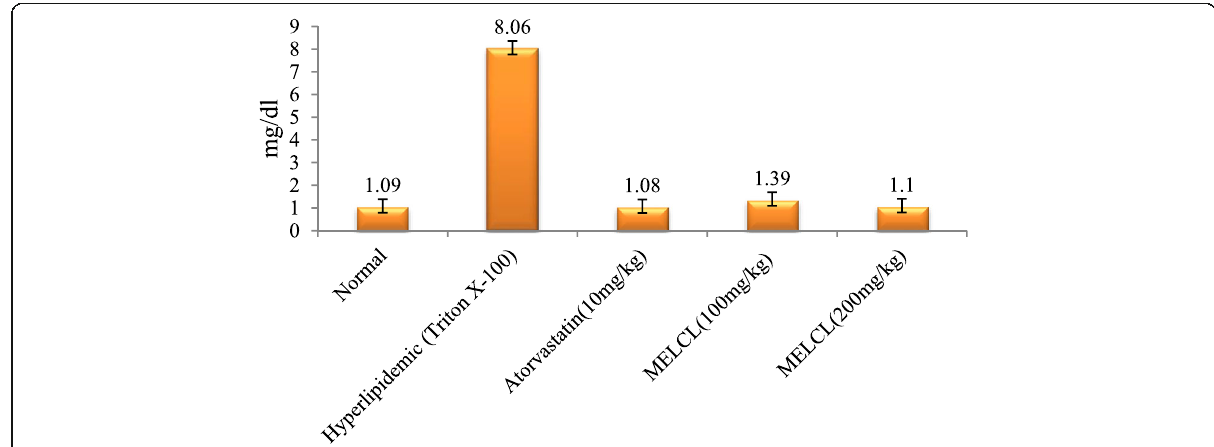
Fig. 3 Atherogenic index analysis for different groups. MELCL: Methanolic extract of Luffa cylindrica (L.) leaves